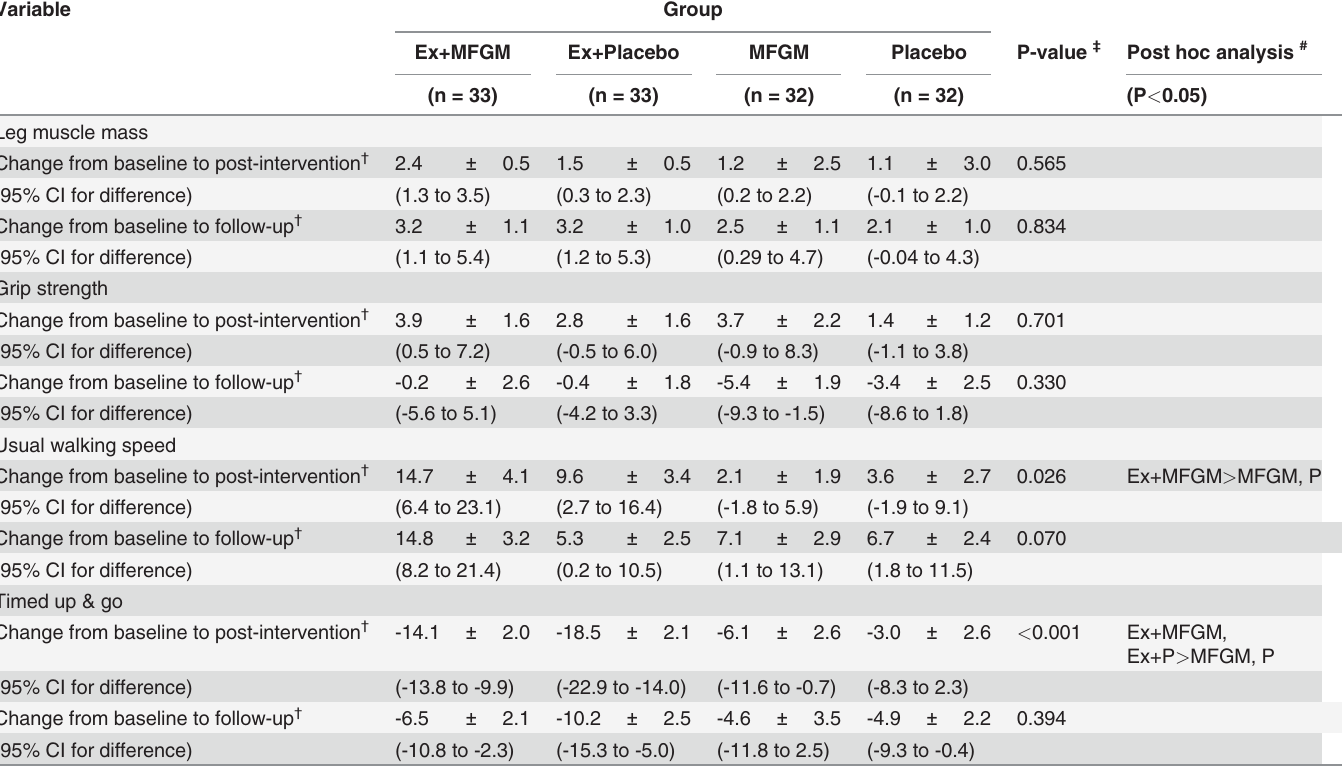
Table 4. Effects of the intervention on each muscle mass and physical function between baseline, post-intervention and follow-up.